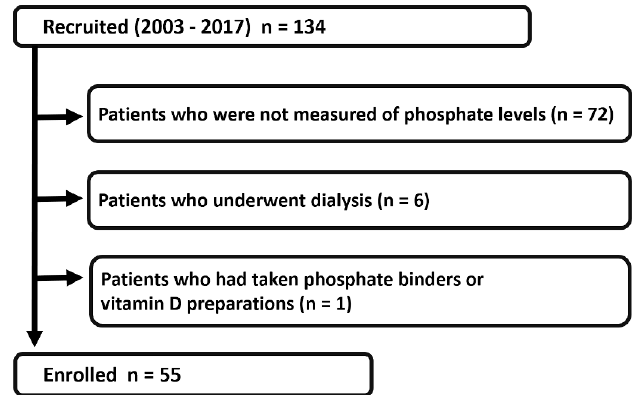
Figure 1. Flow chart of patient selection. From 134 patients screened initially, 72 who missed data regarding phosphate levels, 6 who underwent dialysis, and 1 who had taken phosphate binders or vitamin D preparations were excluded; the remaining 55 patients were enrolled in this study.